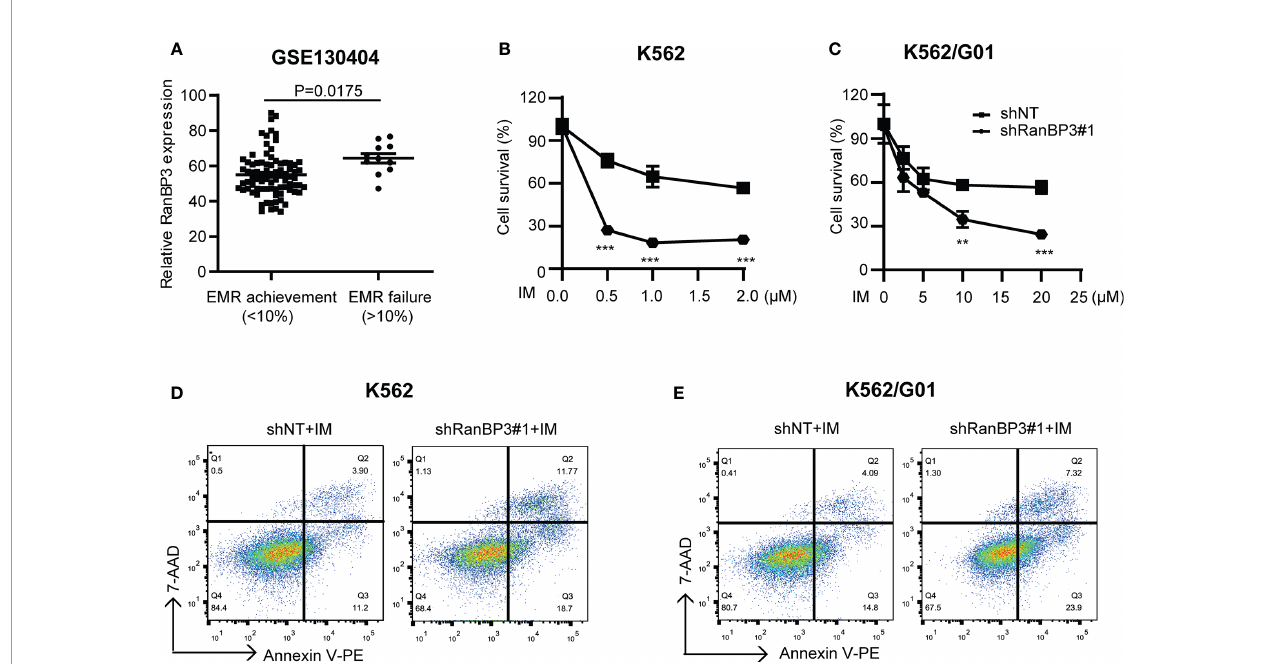
FIGURE 4 | RanBP3 silencing increases the IM-induced apoptosis of CML cells. (A) The database GSE130404 contains 83 patients with early molecular response achieved (EMR achieved: BCR-ABL1 < 10% (IS) at 3 months) and 13 patients with early molecular response failure (EMR failure: BCR-ABL1 > 10% (IS) at 3 months). After excluding the outliers of each group, the P-value of RanBP3 expression of these two groups was calculated. (B, C) K562 (or K562/G01) cells and their derivatives were inoculated in 96-well culture plates (5000 cells/100 m l per well), then treated with different concentrations of IM for 48h. The OD450nm value of each well was measured by CCK-8 and the cell survival rate was calculated. (D, E) Cells were infected with the lentivirus-carrying shRanBP3 and control shRNAs for 48h and followed by IM treatment for 48h (0.5 m M IM for K562, 2 m M IM for K562/G01). Apoptosis was examined by FCM. **P < 0.01, ***P <